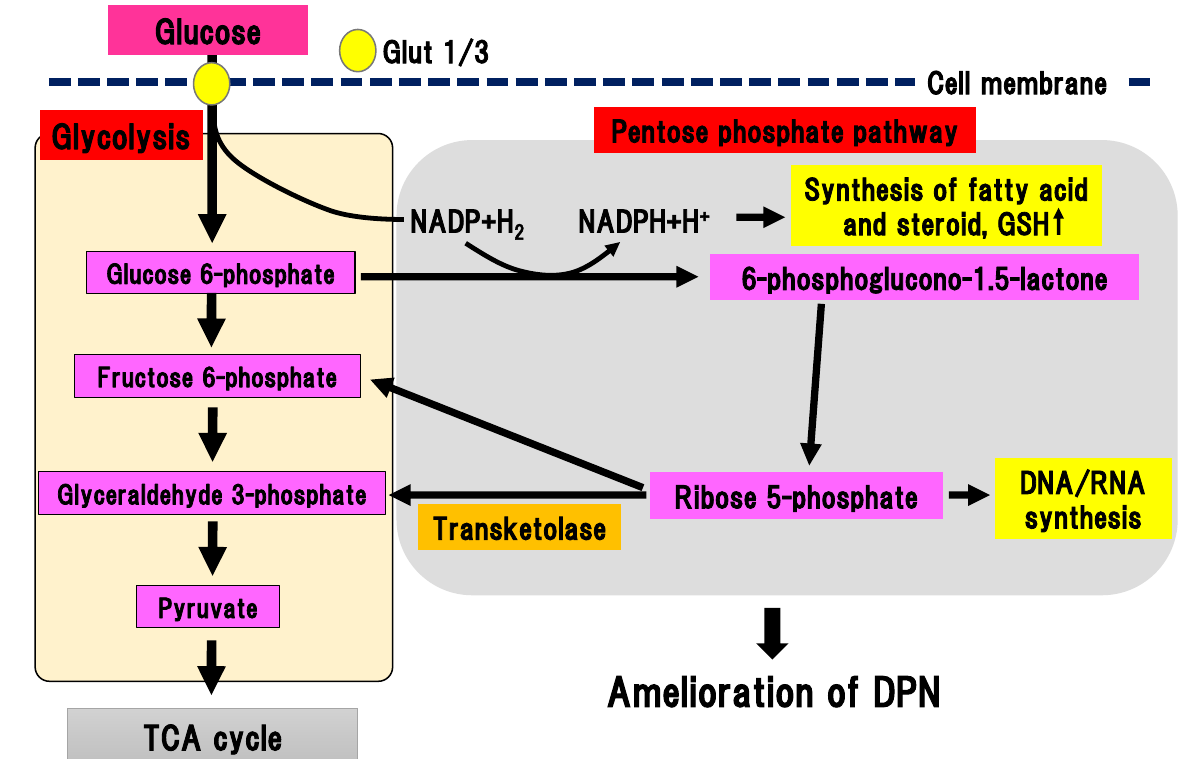
Figure 6. Pentose phosphate pathway. Glucose 6-phosphate is metabolized to a series of pentoses, such as ribose 5-phosphate. Transketolase catalyzes the conversion of ribose 5-phosphate into fructose 6-phosphate and glyceralde- hyde 3-phosphate. DPN, diabetic polyneuropathy; Glut, glucose transporter; GSH, glutathione; NADP(H), nicotinamide adenine dinucleotide phosphate; TCA cycle, tricarboxylic acid